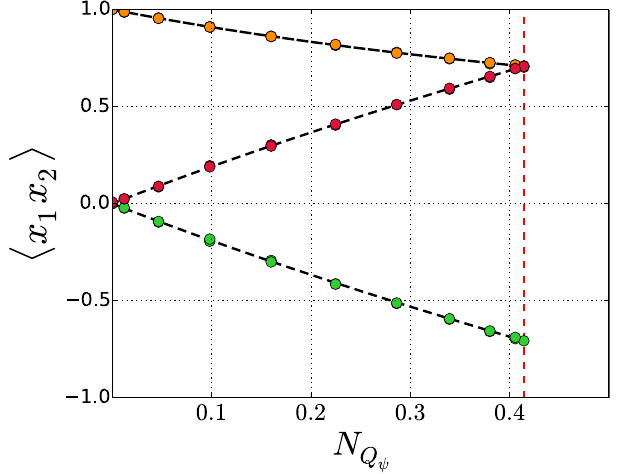
Figure 5. Pair correlations 〈 x 1 x 2 〉 versus nonlocality N Q in the maximally nonlocal CHSH setup. Dots are data ψ produced by a computer implementation of the stochastic process in Fig. 4: 〈 00 〉 = 〈 01 〉 in orange, 〈 10 〉 in red and 〈 11 〉 in green. The lines are the graphs of the quantum-mechanical formulas